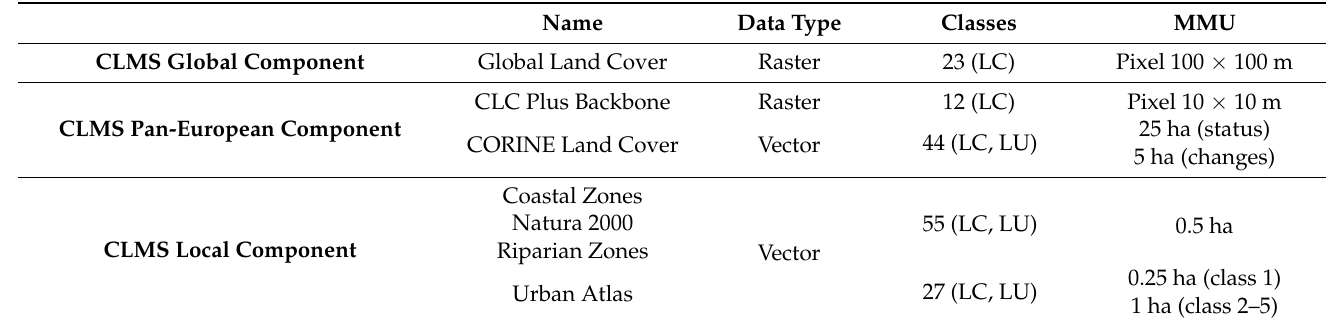
Table 1. Copernicus Land Monitoring Service land cover and land use data with reference to the Global, Pan-European and Local component; LC = Land Cover classes, LU = Land Use classes, CLMS = Copernicus Land Monitoring